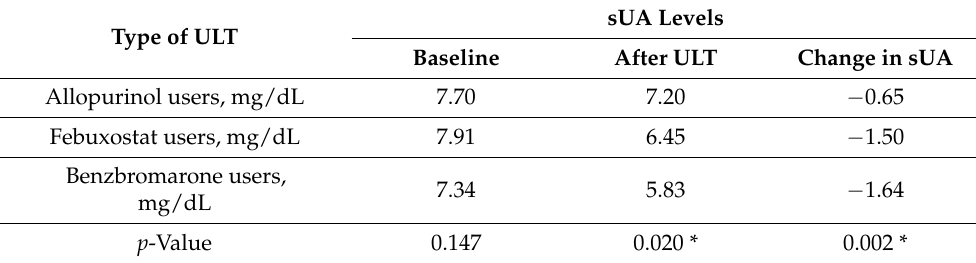
Table 4. Changes in sUA level in patients with gout after treatment with different urate-lowering drugs. sUA Levels Type of ULT Baseline After ULT Change in sUA Allopurinol users,